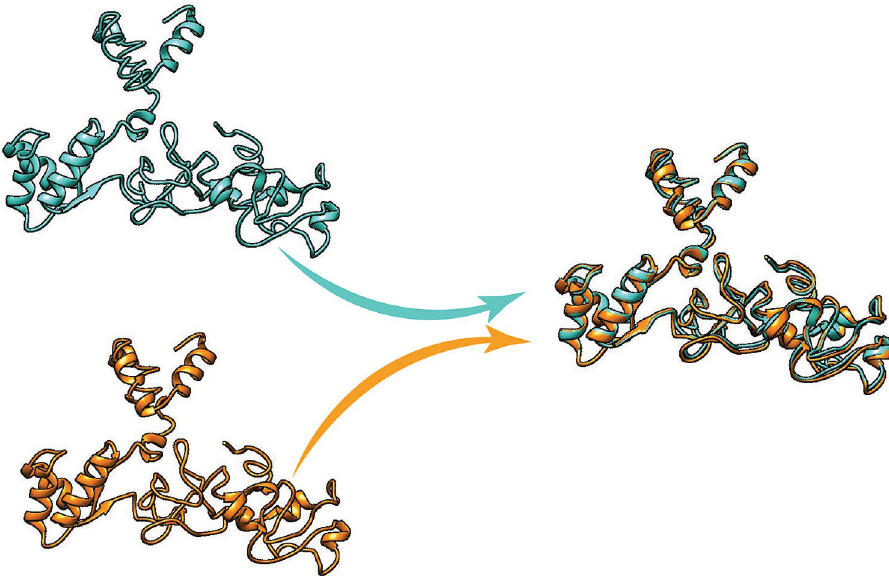
Figure 4. The unrefined and refined structures of the 3D model of the vaccine. The unrefined structure is shown in blue, while the refined structure is shown in orange. To identify the differences between the unrefined and refined structures, the structures were superimposed.